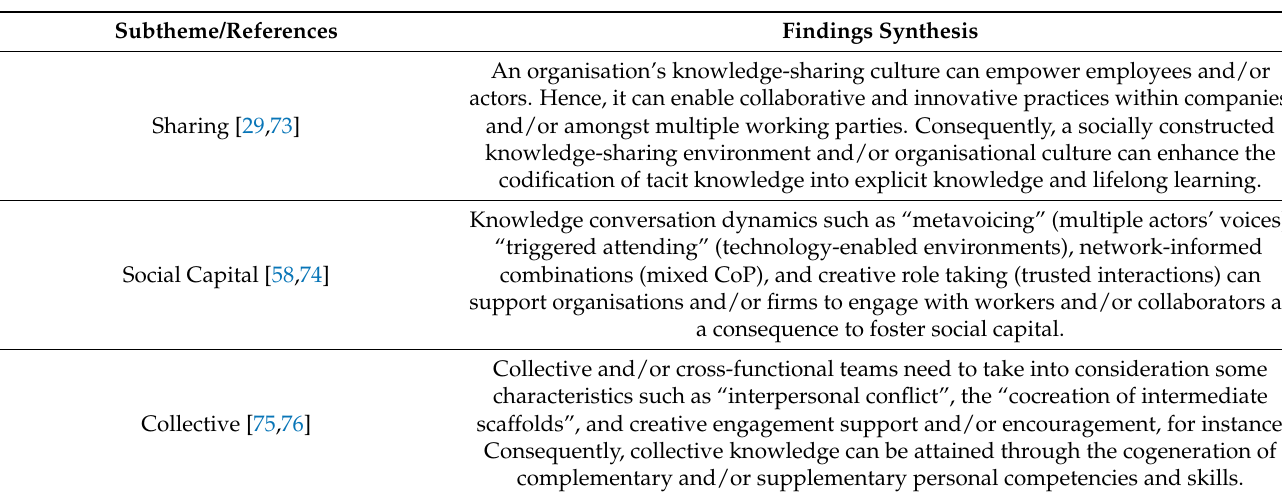
Table 3. Dynamics and mobile devices, or creativity on the move.